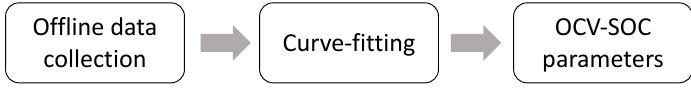
Figure 1. Empirical OCV-SOC characterization.